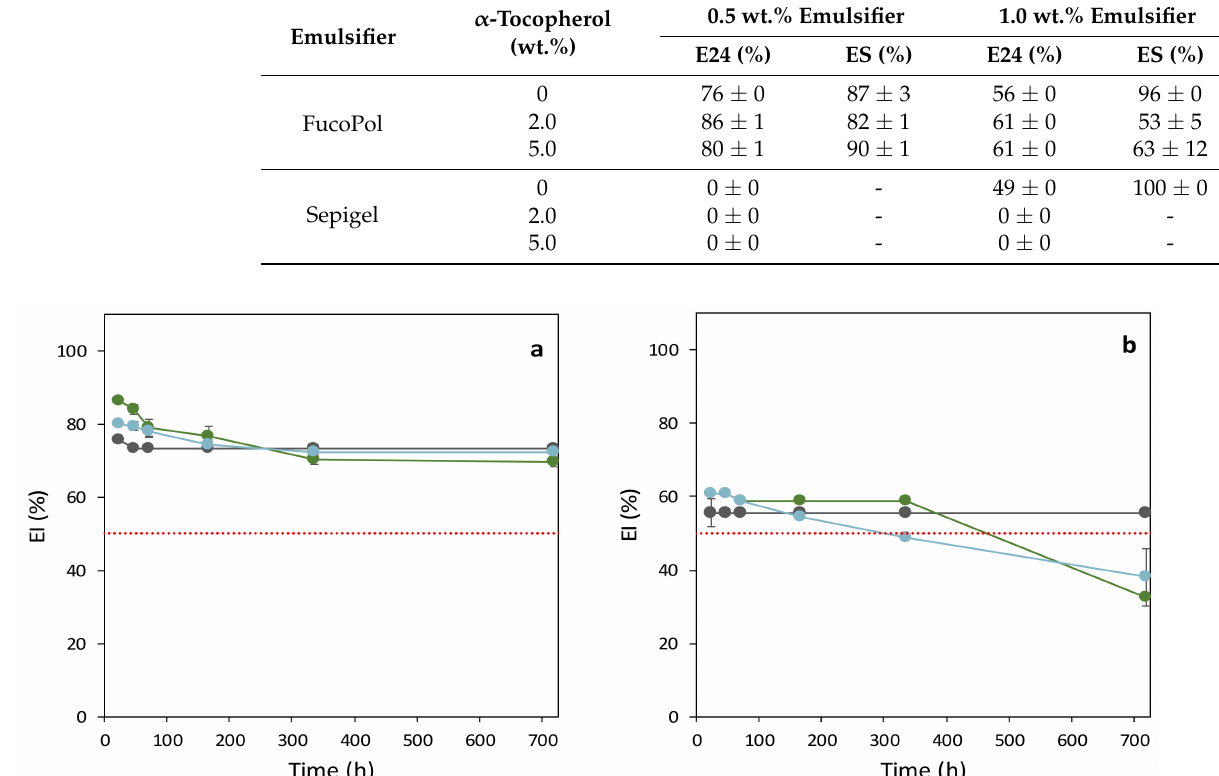
Table 3. Emulsification activity at 24 h (E24) and emulsions’ stability over a period of 720 h, for the emulsion prepared with FucoPol, olive oil and α -tocopherol, at 3:2 ( w / w ) ratio. Data are shown as the average ± standard deviation (SD) ( n = 3).